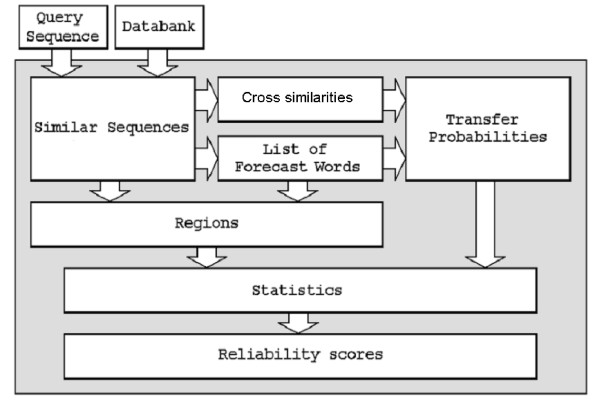
A4 algorithm scheme.